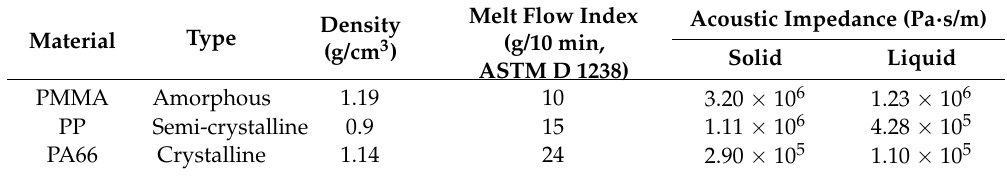
Table 1. Material properties of the investigated materials. PA66: polyamide 66; PMMA: polymethyl methacrylate; PP: